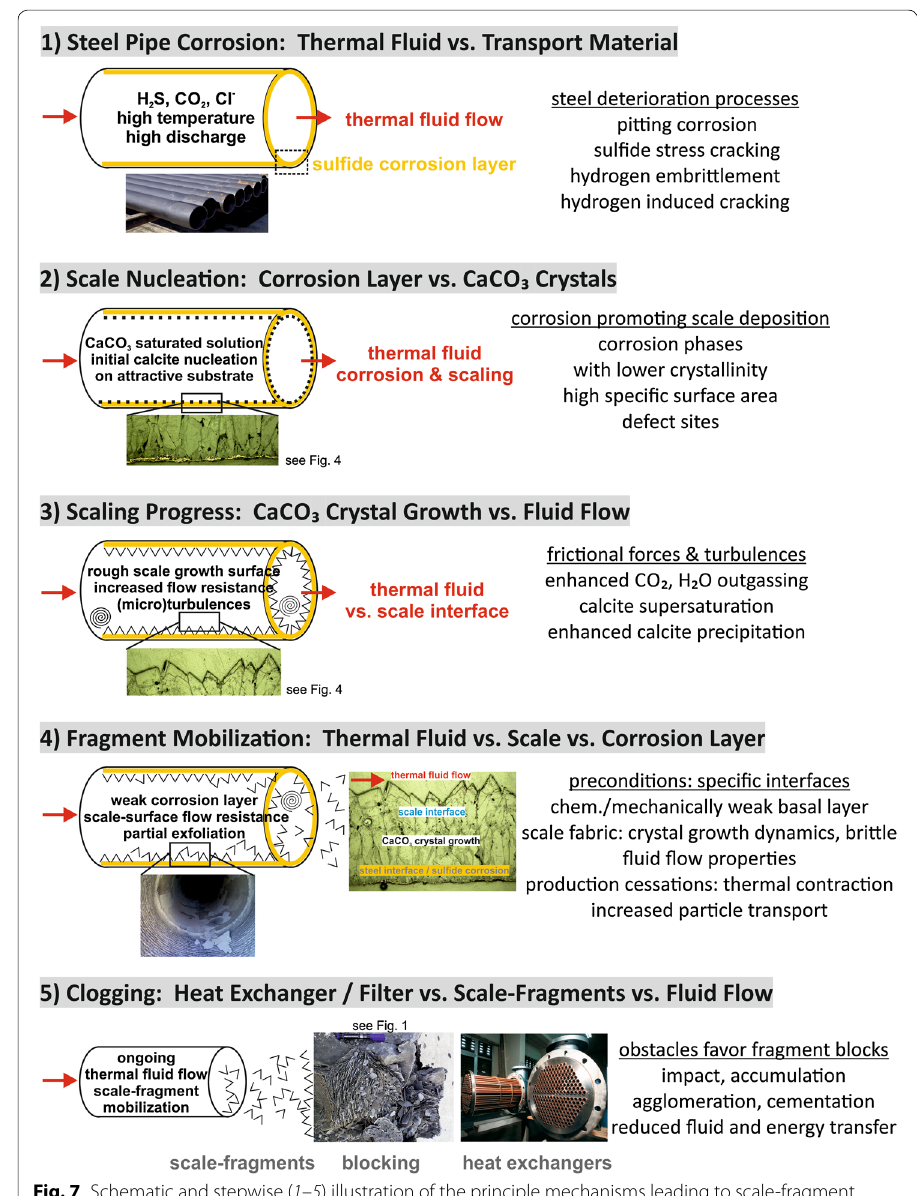
Fig. 7 Schematic and stepwise ( 1 – 5 ) illustration of the principle mechanisms leading to scale-fragment development in pipes ( vertical or horizontal ) and finally resulting in heavy blockage of heat exchangers or other obstacles (e.g., filters). This conceptual model might also be applied in other cases of problematic scale- fragment